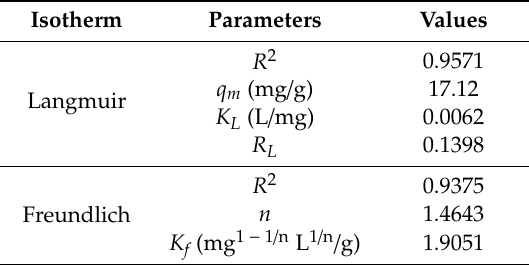
Table 1. Equilibrium isotherm